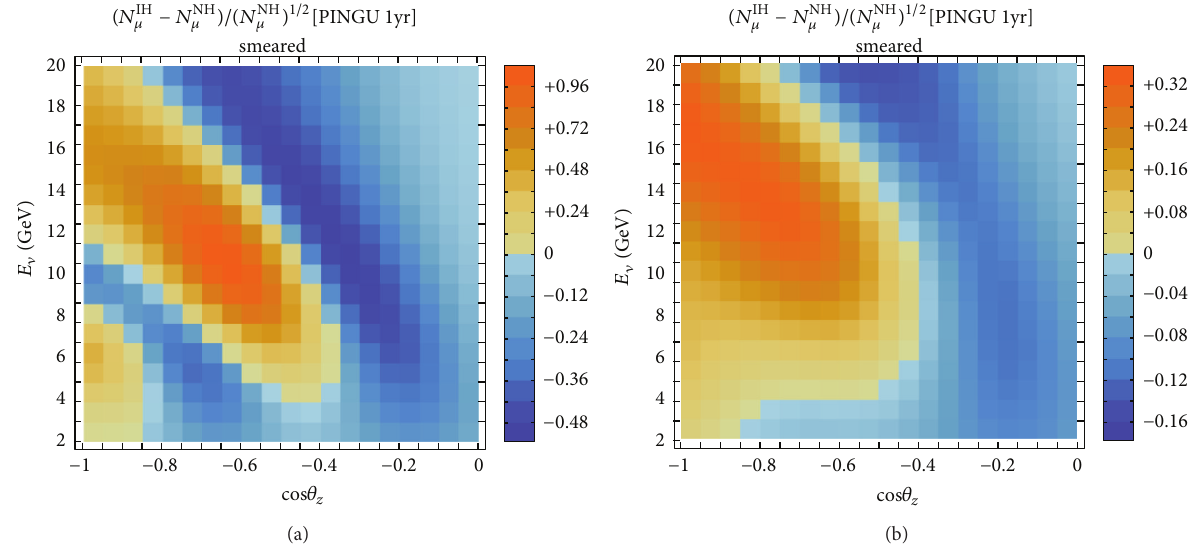
Figure 7: Statistical significance per bin of the difference between NH and IH for one year of PINGU data from 𝜈 𝜇 -induced events, binned in neutrino energy (bin width Δ𝐸 𝜈 = 1 GeV) and cosine of the zenith angle (bin width Δ cos 𝜃 𝑧 = 0.05 ). In the left (right) panel neutrino energy and angular reconstruction resolutions of 2 (4) GeV and 11.25 ∘ ( 22.5 ∘ ) have been assumed. Figures from [76].